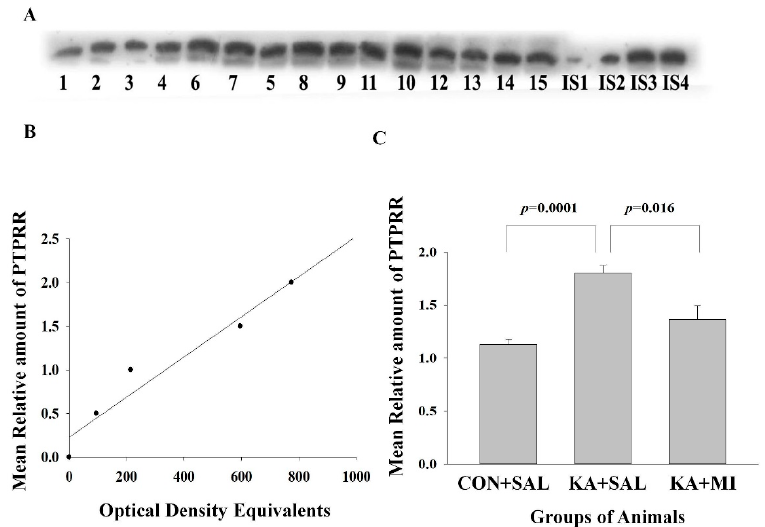
Figure 6. PTPRR protein is increased in the hippocampus of KA + SAL animals. ( A ) Sample film, where each lane corresponds to one sample. Lanes 1–5 are from CON + SAL group; lanes 6–10 from KA + SAL group and lanes 11–15 from KA + MI group. Lanes IS-1-IS4 are internal standards containing, respectively, 15, 30, 45, and 60 μ g protein. ( B ) Calibration plot (lines fitted by linear least-squares regression); ( C ) Mean levels of PTPRR (mean ± sem).